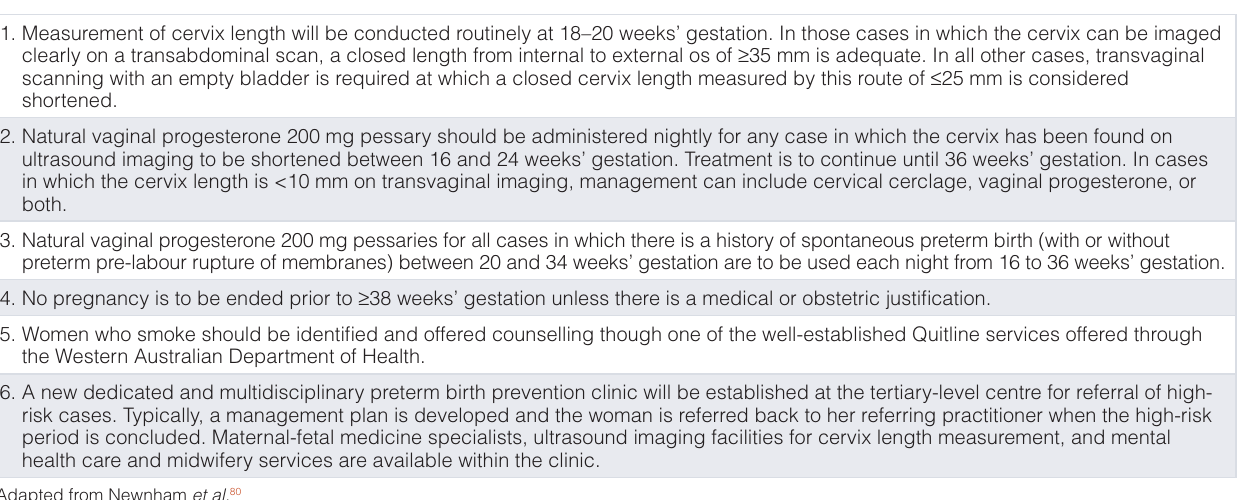
Table 1. Key interventions of the Western Australian Preterm Birth Prevention